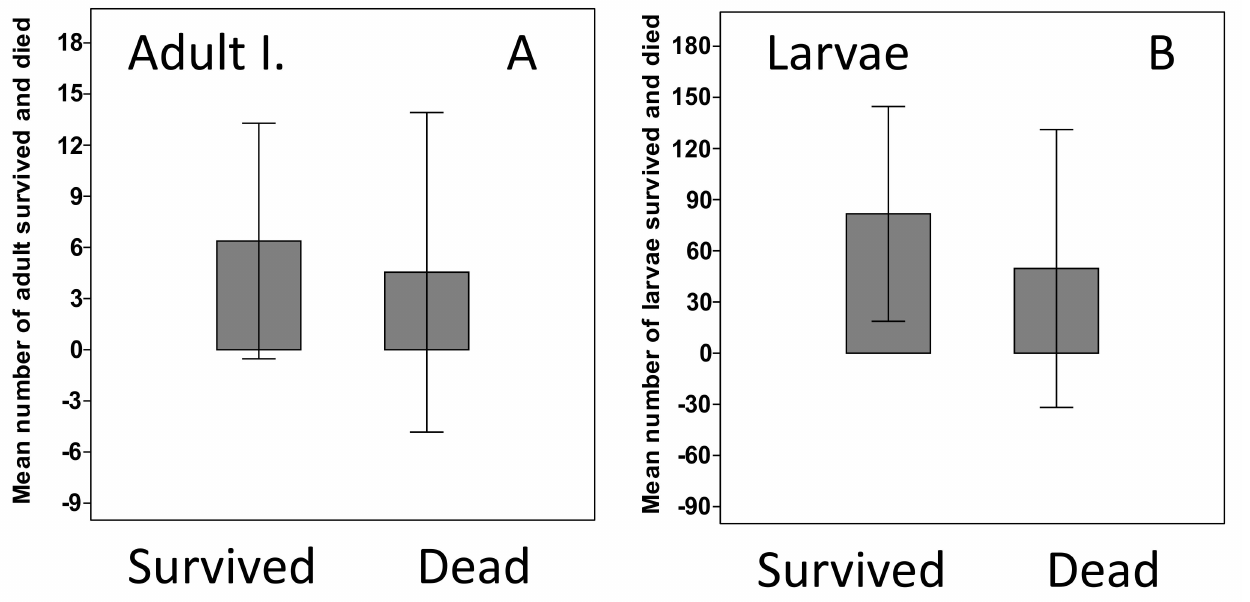
Figure 4. PCoA and linear correlation (bars) to test the influence of log diameter on treatments effects (determined by maternal gallery length), where the log length was considered as the main component, and the maternal gallery length was considered as the